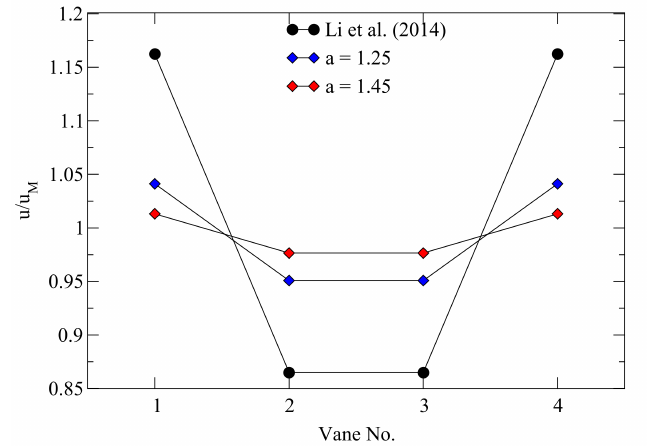
Figure 7. Numerical results for the a = 1.65 in-line bundle.